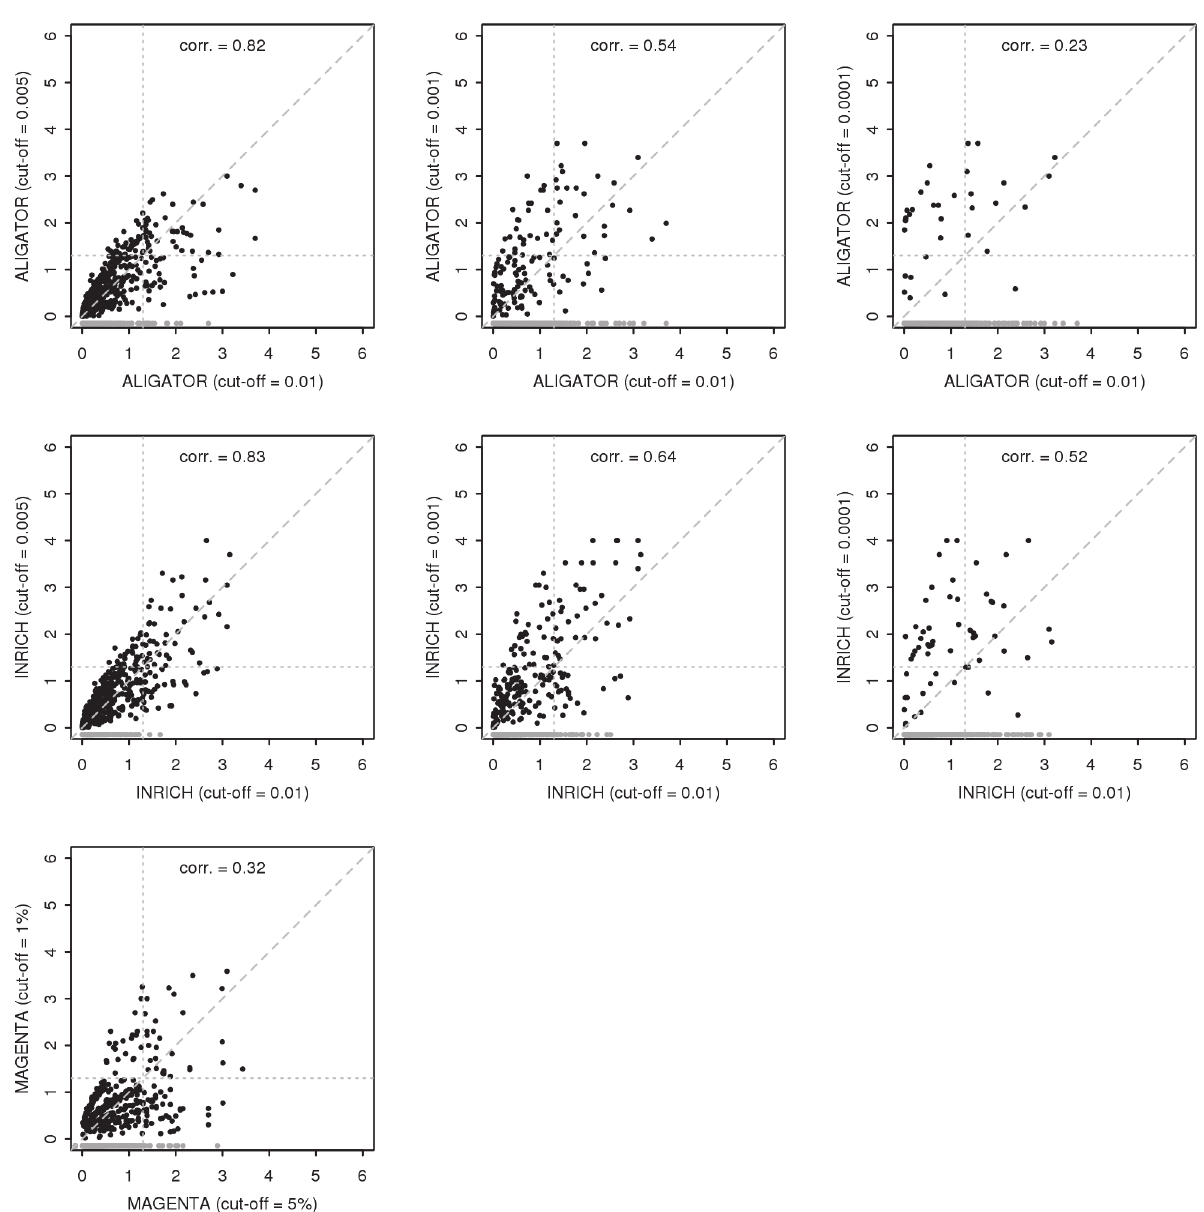
Fig 4. Comparison of competitive gene-set analysis results at different SNP cut-offs. Comparison of gene set − log10 p-values from the CD data competitive gene-set analysis at different SNP p-value cut-offs for ALIGATOR (top row), INRICH (middle row) and MAGENTA (bottom row). The highest cut- off on the horizontal axis is compared to each of the lower cut-offs. P-values for gene sets not evaluated at the lower cut-off are shown in grey. The shown correlations are for the − log10 p-values for gene-sets evaluated at both cut-offs. Horizontal and vertical grey dotted lines demarcate the p = 0.05 nominal significance